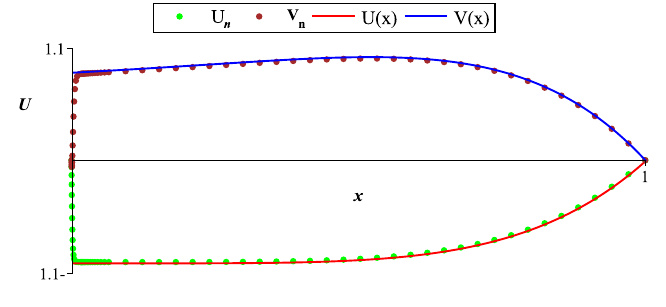
Figure 3. Numerical solution of Example 5 using (SCA) and N = 64 on non-uniform mesh.